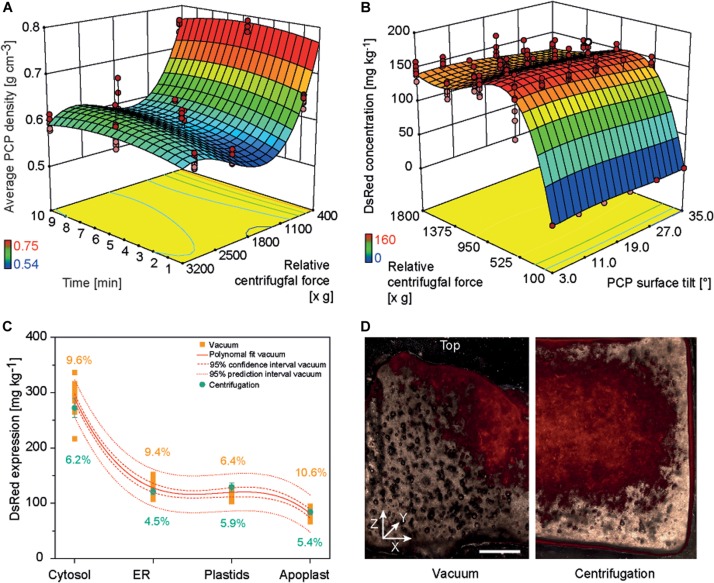
PCP density and DsRed accumulation in PCPs generated by centrifugation or vacuum. (A) Response surface of PCP average density as a function of relative centrifugal force (rcf) and treatment time following centrifugation. (B) Response surface of DsRed expression as function of rcf and PCP surface tilt angle following the removal of bacterial suspension by centrifugation. (C) Comparison of DsRed levels in PCPs generated by vacuum or by centrifugation. (D) Fluorescence images (530 nm excitation, 590 nm emission) of PCPs generated by vacuum (left half) and centrifugation (right half) and cut in the XZ (width × height) plane (∼0.5 mm thickness). Horizontal size of scale bar is 1 mm. The vertical white line indicates the center of each PCP. The Z-axis of the coordinate system is directed toward top of the PCP.